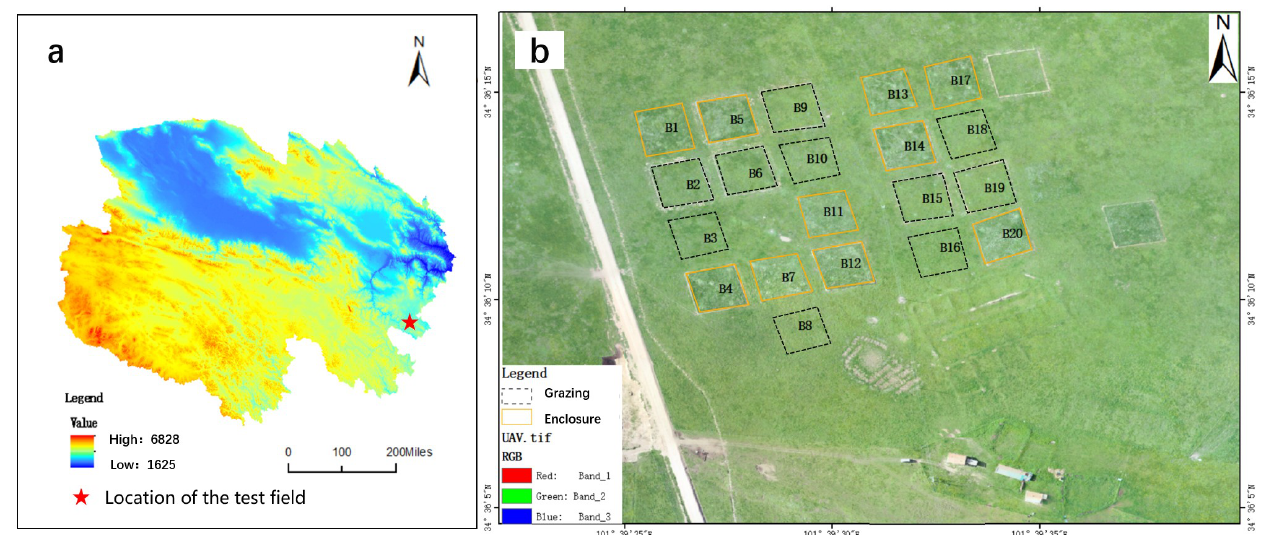
Figure 1. Overview of the study area. ( a ) Digital elevation model (DEM) map of Qinghai Province, China, where the study area is located. ( b ) A drone view of the test site. Image bands are red, green, and blue. Ten of the sample plots were enclosed, while the other ten were allowed to be freely